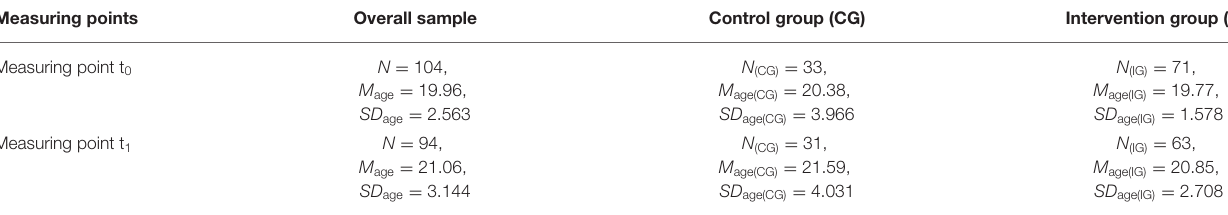
TABLE 1 | Overview sample at t 0 and t 1 ( N and mean and standard deviation of age).